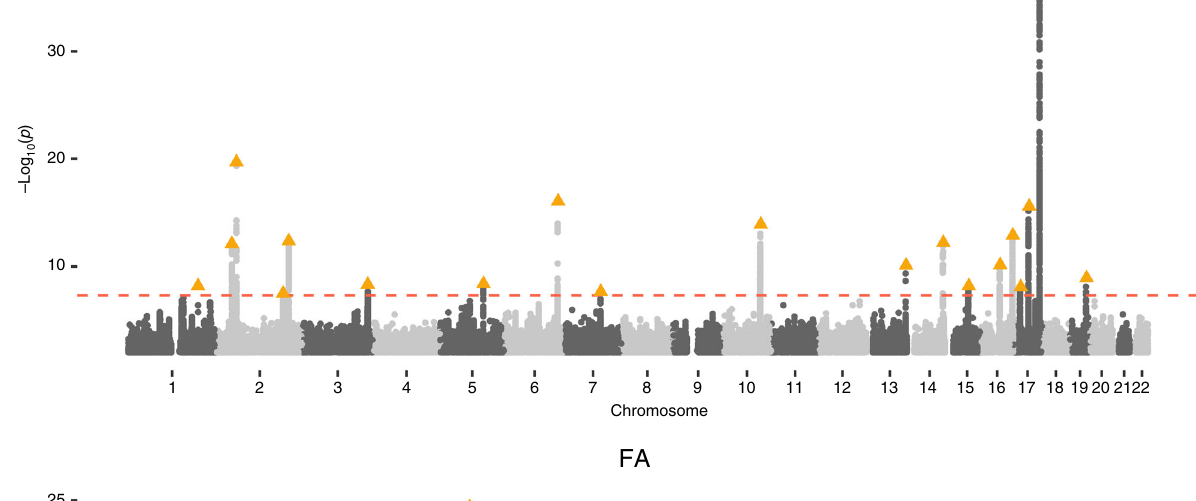
with high genetic correlation estimates (WMH/FA: r g = − 0.25, se = 0.06, p = 3.2 × 10 − 5 ; WMH/MD: r g = 0.41, se = 0.08, p = 8.7 × 10 − 8 ; FA/MD: r g = − 0.77, se = 0.03, p = 2.7 × 10 − 114 ). We also assessed the genetic correlation between our imaging biomarkers and traits from 479 available GWAS summary